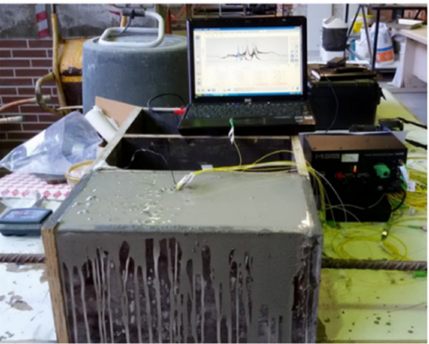
Figure 4. RC sample after filling with